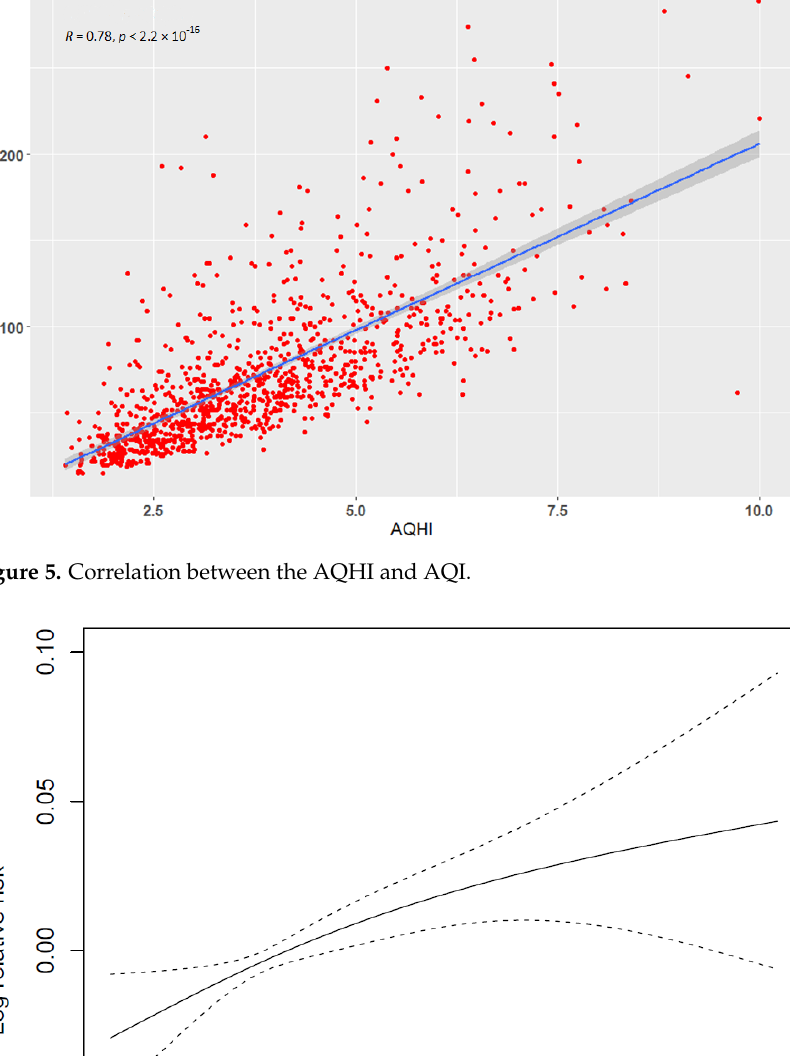
Table 5. Comparative statistics of the AQI and AQHI in Beijing from 2018 to 2020.